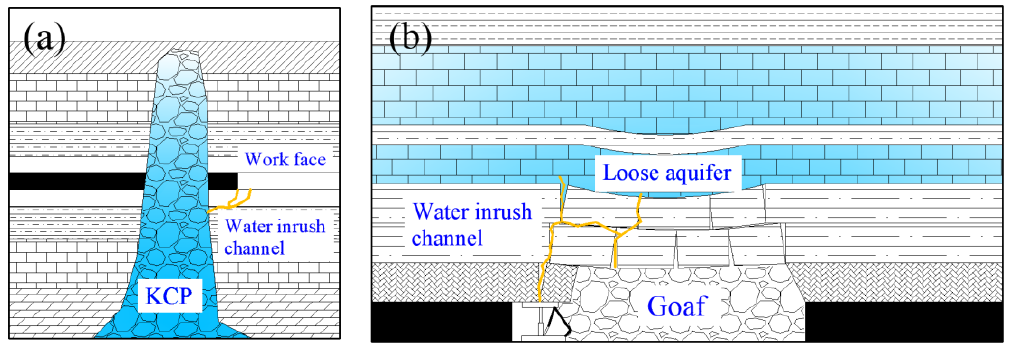
Figure 1. Water inrush in tunnel engineering. Figure 2. Water inrush in underground mining: ( a ) karst collapse pillar (KCP); ( b ) water inrush from roof.